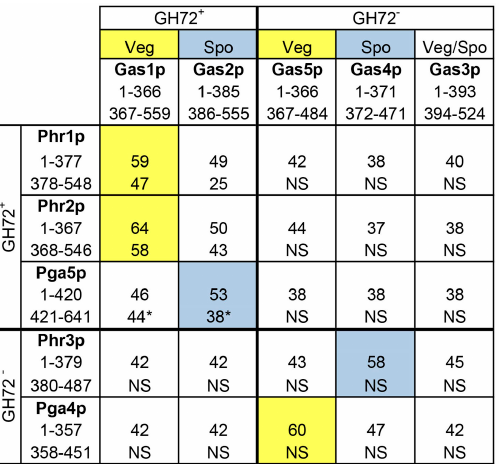
Table 1. Catalytic properties of Phr proteins of Candida albicans 1 .